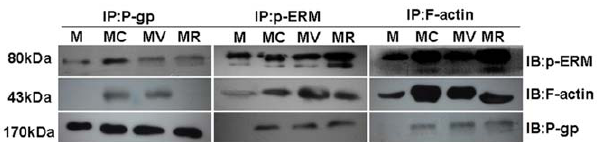
Figure 4. P-gp, ERM and F-actin co-immunoprecipitation induced by CCL25 in MOLT4 cells. Western blot for p-ERM, F-actin, and P-gp in P-gp (left panel), p-ERM (middle panel) and F-actin (right panel) immunoprecipitations, respectively, from lysates of MOLT4 cells in the presence or absence of CCL25.